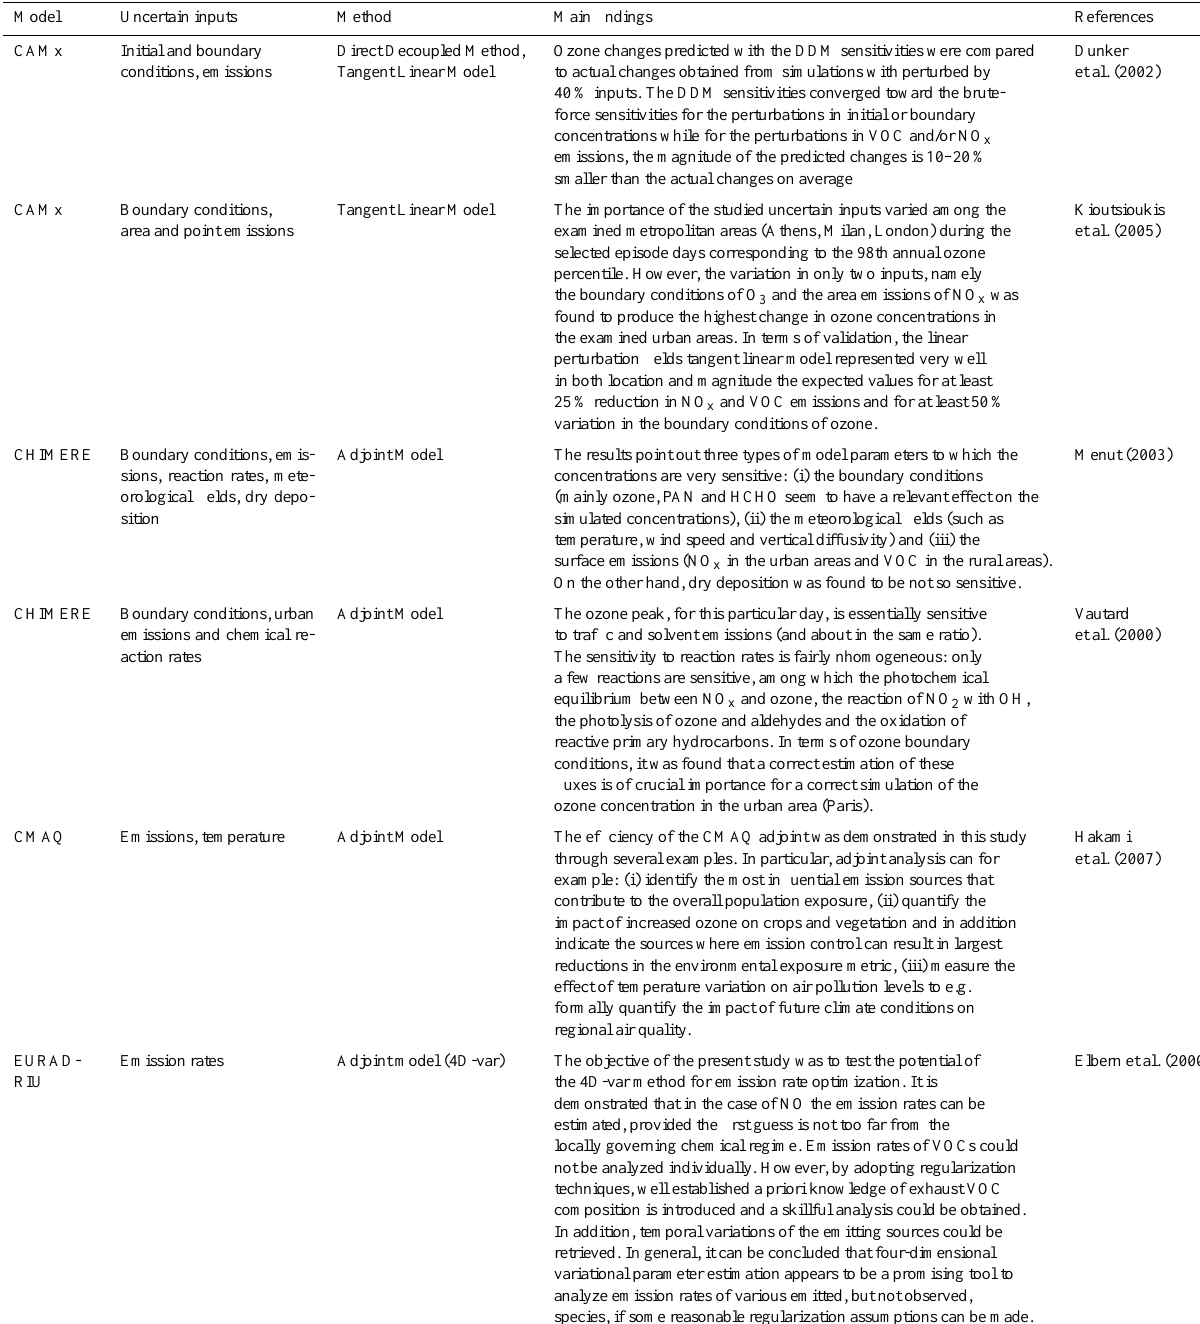
Table 13. Brief demonstration of some sensitivity analysis applications with the examined CWF